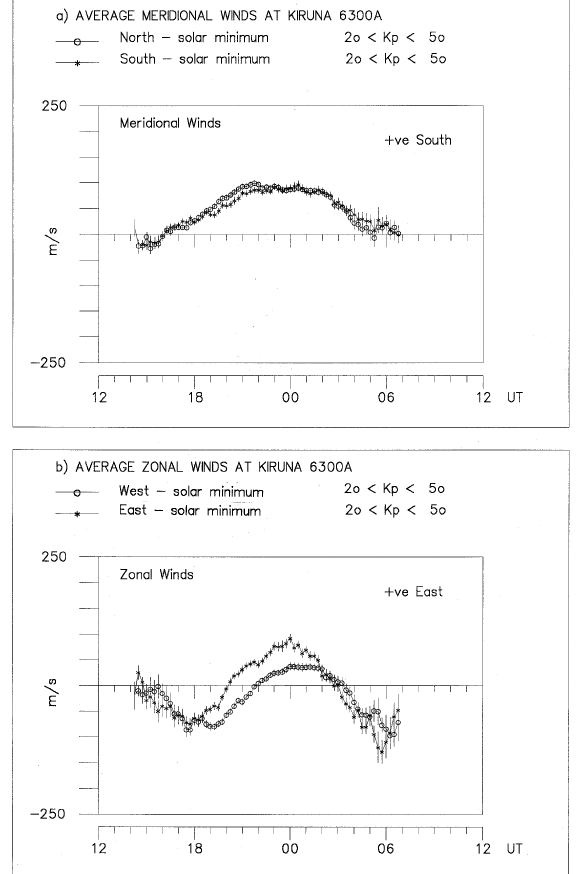
Fig. 6. Comparison of the (a) average meridional and (b) average zonal components of the neutral winds observed to the North and South, and to the East and West of Kiruna, respectively. The peak emission height of the 630 nm emission is around 240 km. As a re- sult a horizontal distance of over 800 km separates the observations in opposite